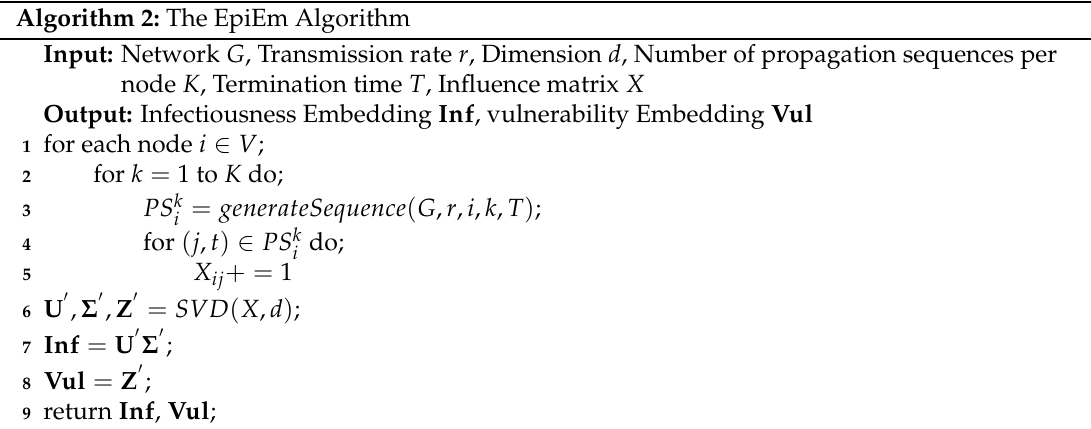
Algorithm 2: The EpiEm